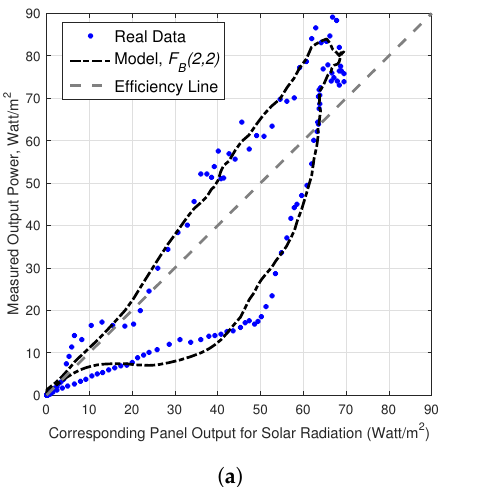
Corresponding Panel Output for Solar Radiation (Watt/m 2 )